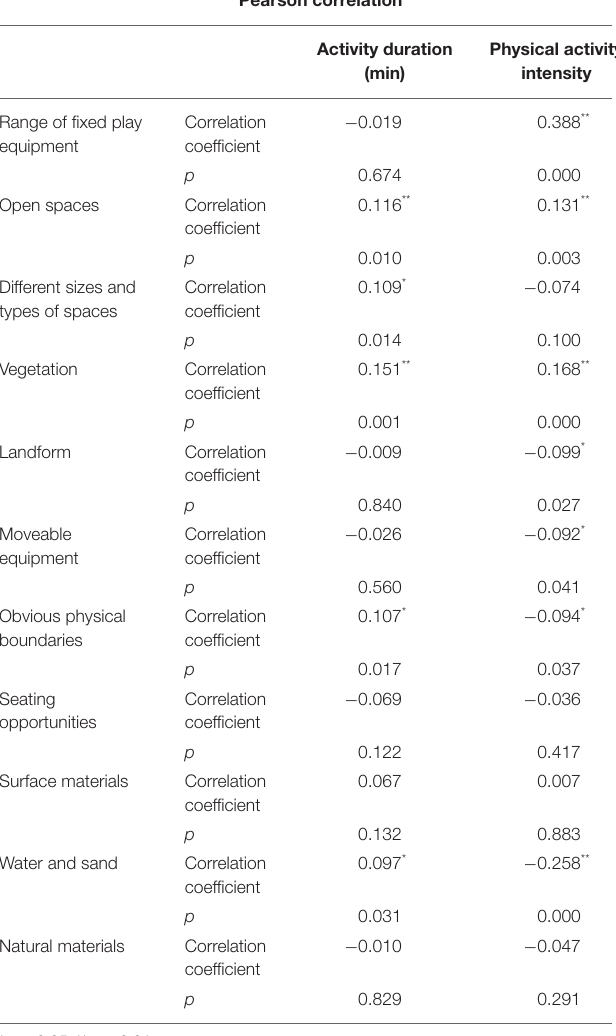
TABLE 5 | Correlation analysis of the duration and intensity of children’s physical activity and neighborhood environmental factors. Pearson